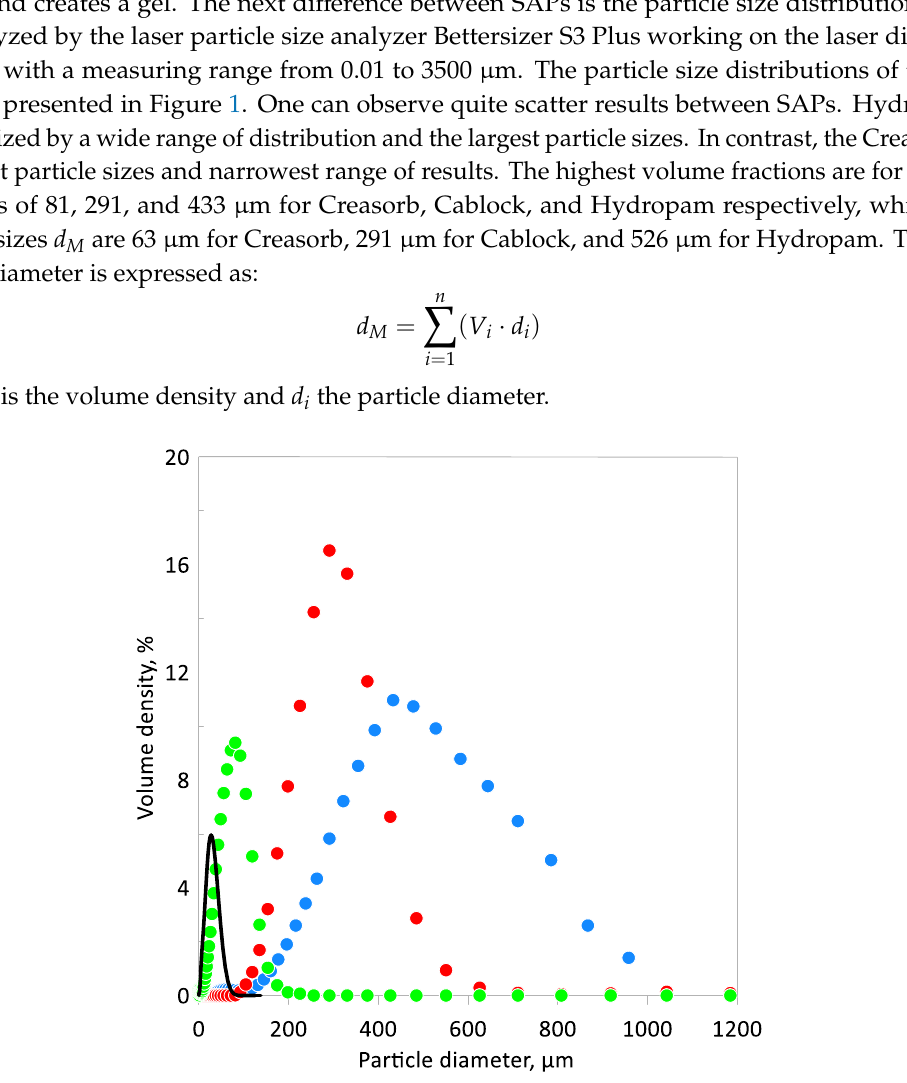
Figure 1. Particle size distribution of superabsorbent polymer (SAP) ● Cablock CT, ● Hydropam, and ● Creasorb